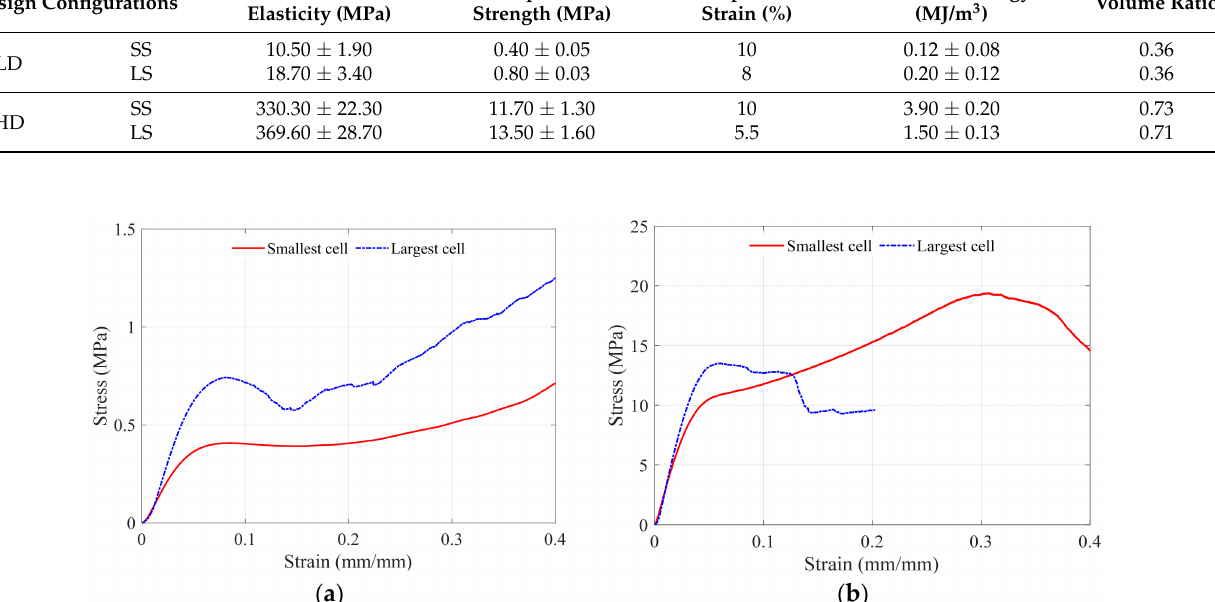
Figure 10. Stress-strain curves for different cell sizes at ( a) LD and ( b ) HD.